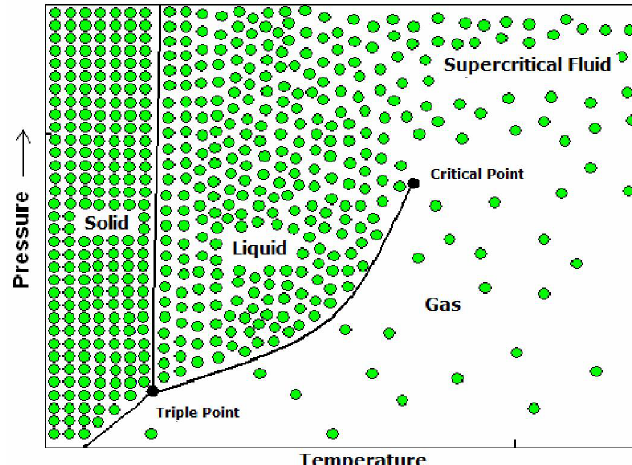
Figure 1 Phase diagram showing supercritical fluid